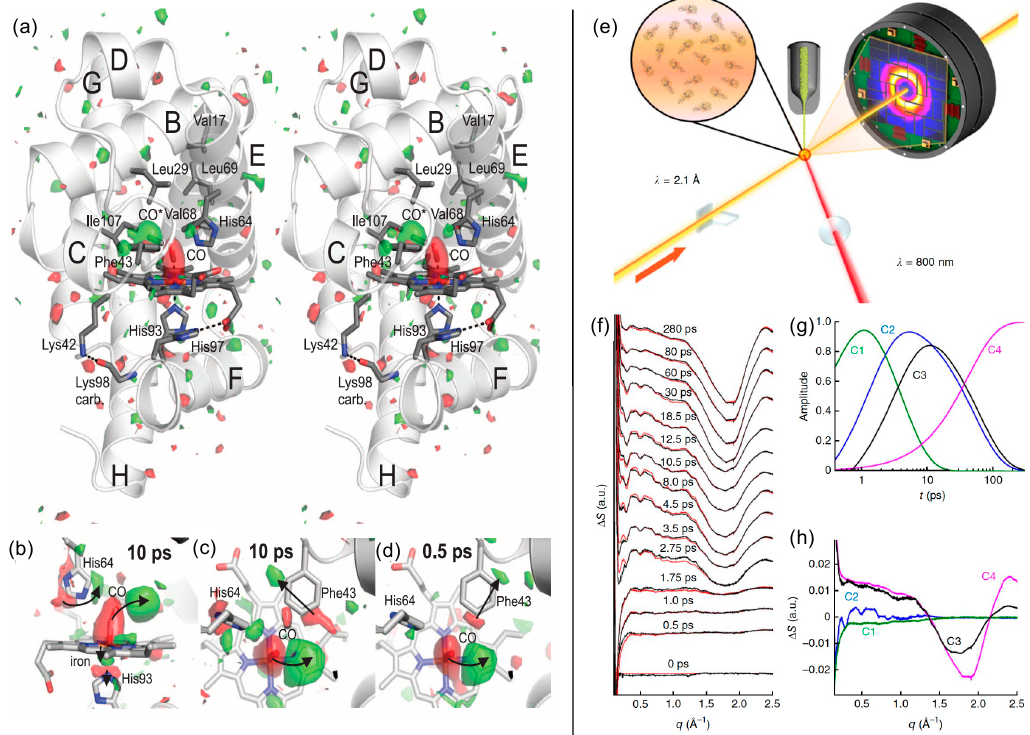
Figure 9. Time-resolved fs-X-ray diffraction and scattering. Left panel: ( a ) stereo image showing the structure of Mb, as well as the electron density difference following photoexcitation for t = +0.5 ps (contoured at +3 σ (green) and –3 σ (red)). There are clear structural changes in the vicinity of the heme. ( b – d ) Difference electron density maps showing bound (–3 σ contour level, red) and photodissociated (+3 σ , contour level green) CO, doming of the heme, out-of-plane movement of the iron, and concomitant movement of His93 away from the heme, as well as rotation of His64 and movement of Phe43, which is displaced in different directions at t = +0.5 ps and t = +10 ps. The orientation in ( b ) is rotated by 90° with respect to the orientation in ( c ) and ( d ). Figure adapted from Reference [107] with permission from Science AAAS. Right panel: Time-dependent changes in wide-angle X-ray scattering (WAXS) data recorded from detergent-solubilized samples of RC vir . ( e ) Experimental setup illustrating the microjet of solubilized RC vir (green), X-ray detector, XFEL beam (orange) and 800-nm pump laser (red). ( f ) Time-resolved WAXS structure factor difference, ∆ S(q, t ) = S light (q, t ) – S dark (q), recorded as a function of t . Linear sums of the four basis spectra (red) shown in (h) are superimposed upon the experimental difference data (black). ( g ) Time-dependent amplitudes of the components C1–C4 used to extract the basis spectra. ( h ) Basis spectra extracted from the experimental data by spectral decomposition. Figure adapted from Reference [113] with permission from Springer